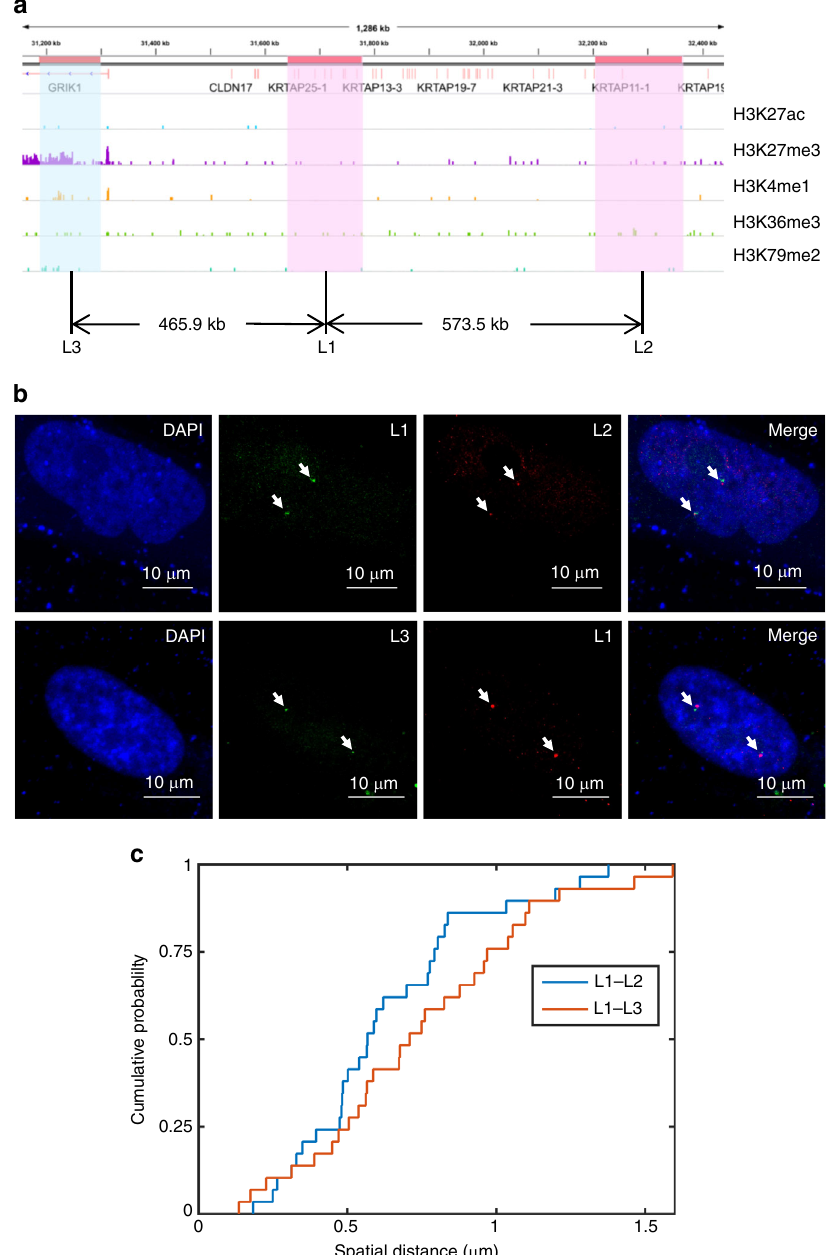
Fig. 6 An experimental evidence that genomic loci from the same subcompartment tend to colocalize. a The ChIP-Seq pro fi les of different histone marks for the three loci L1, L2, and L3 examined in the FISH experiment. Locus L3 is relatively enriched with the mark H3K27me3 and depleted from the mark H3K36me3, and hence considered belonging to subcompartment B1. On the other hand, the two loci L1 and L2 are depleted from the marks H3K27me3, H3K27ac, H3K36me3, H3K4me1, and H3K79me2, and hence considered belonging to subcompartment B2. b One example of the experimental FISH images for the two loci L1 and L2 (top), and for the two loci L1 and L3 (bottom). c The cumulative distribution function (CDF) curves of the distances between L1 and L2 and between L1 and L3, indicating the tendency of the two loci L1 and L2 (belonging to the same subcompartment B2) to lie spatially closer to each other than the other two loci L1 and L3 (belonging to subcompartments B2 and B1, respectively), in spite of the smaller genomic distance between L1 and L3 than between L1 and L2. Data from 35 individual imaged copies of Chr21 were used to generate ( c